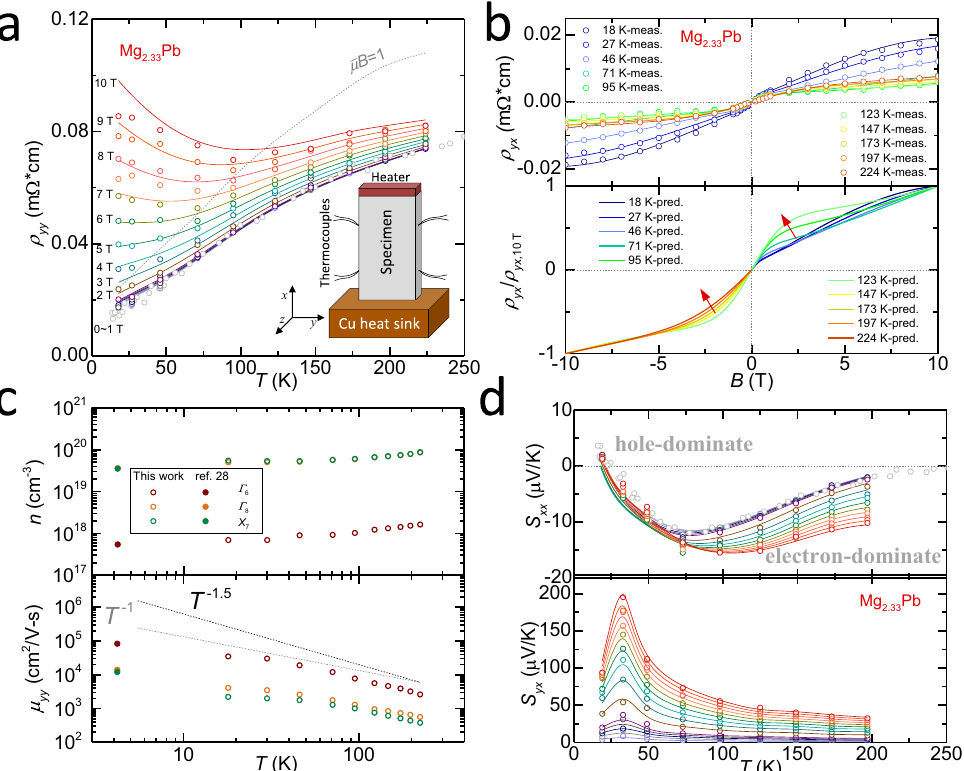
Fig. 5 Transport properties. Temperature ( T ) and fi eld ( B ) dependent transport properties for Mg 2.33 Pb along with the model predictions. a Resistivity ( ρ yy ), inset: the measurement setup. b Hall resistivity ( ρ yx ), the evolution of the low- fi eld features with increasing temperature is indicated by the red arrows. c The estimated carrier concentration ( n ) and mobility ( μ ) for individual band, with a comparison to the literature results 26 . d Longitudinal ( S xx ) and transverse ( S yx )